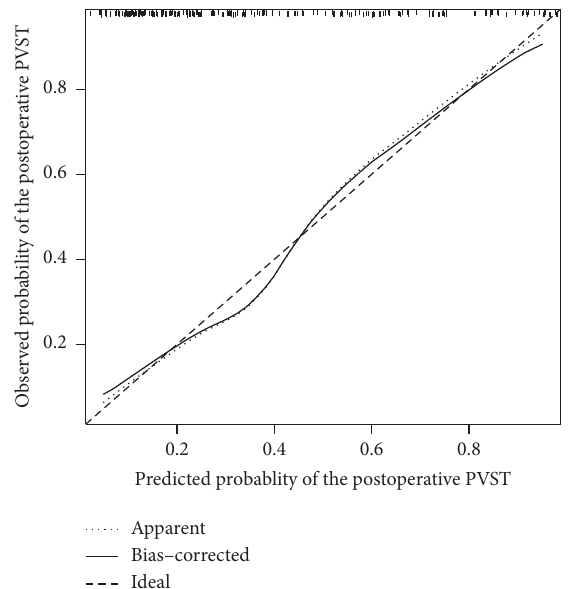
Figure 4: Calibration curve of the nomogram for the prediction of portal venous systemic thrombosis (PVST). Te x -axis represents the predicted risk of PVST using the nomogram, and the y -axis represents the observed